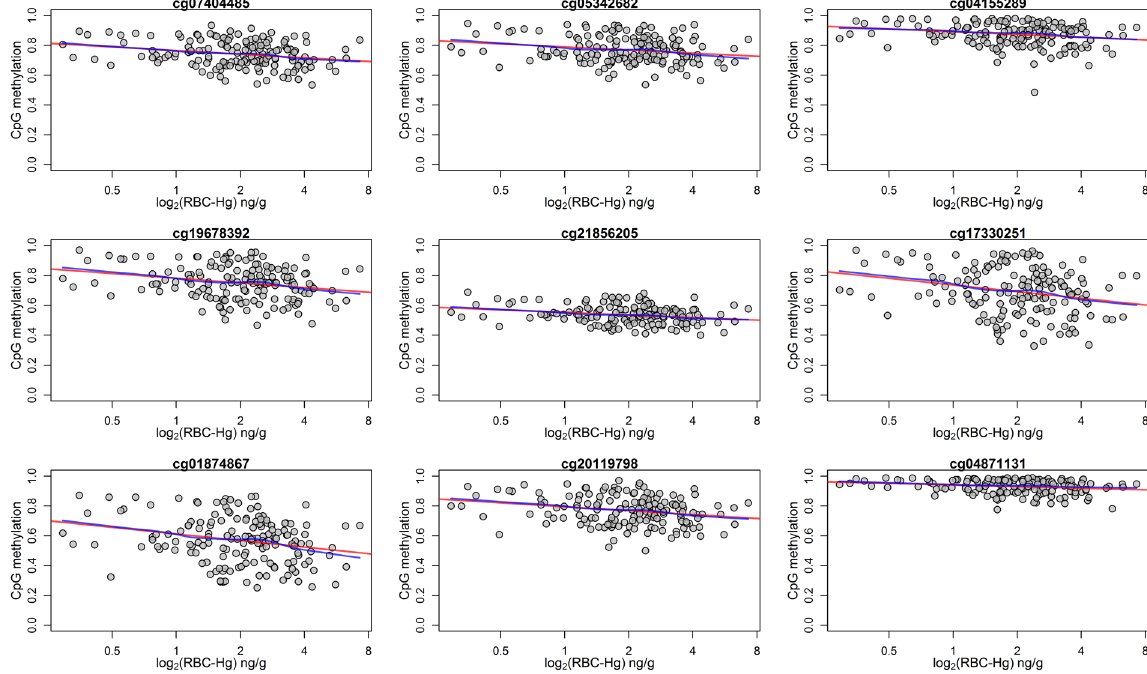
Figure 2. Scatterplots for the associations between individual cord blood CpG methylation in the DMR of the PON1 gene and log 2 -transformed prenatal mercury exposure: red (fitted simple linear regression line) blue (locally weighted scatterplot smoothing).